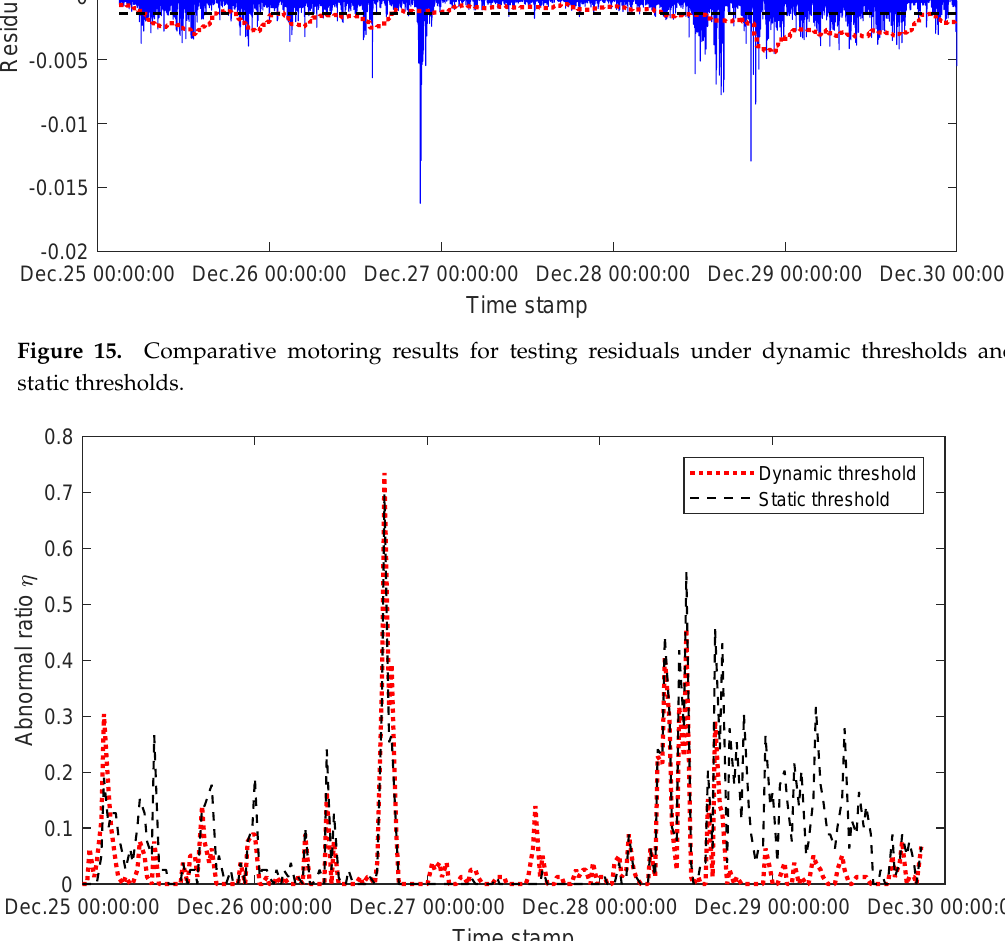
Figure 16. Comparative results of abnormal ratio curves for the testing residuals under dynamic thresholds and static